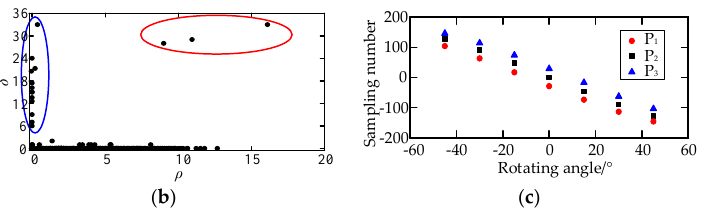
Figure 6. The TDs and decision diagram at O 2 when SNR = 5 dB. ( a ) The TDs at the measurement point O 2 ; ( b ) The decision diagram when α j = 0°; ( c ) The separated TD center sequences at O 2 . Table 2. The characteristic parameters of the three measurement points when SNR = 5 dB.